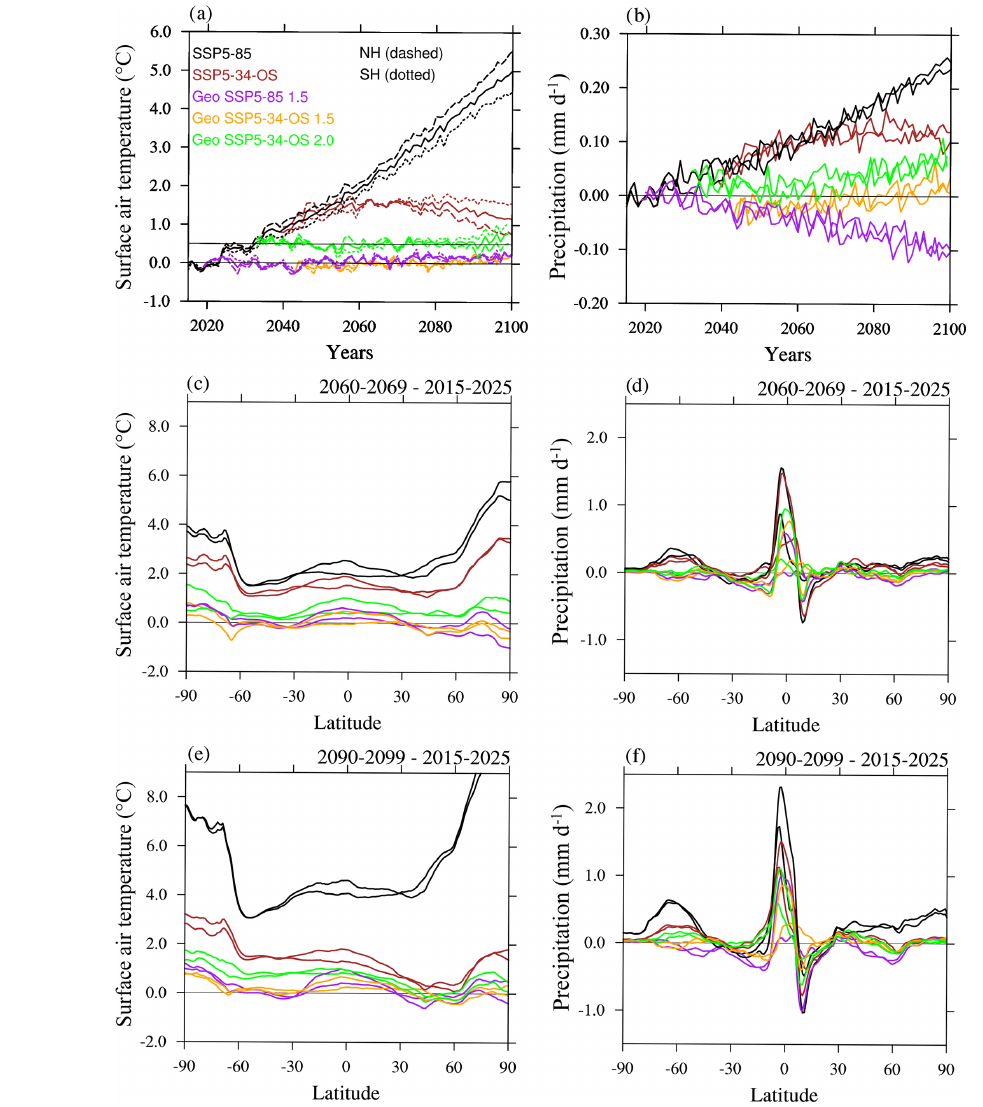
Figure 4. (a) Time evolution of the ensemble mean area-weighted annual mean surface air temperature with regard to 2010–2025 conditions, averaged over the globe (solid), over the Northern Hemisphere (dashed), and over the Southern Hemisphere (dotted) for different model experiments (different colors; see legend); (b) time evolution of area-weighted annual precipitation with regard to 2015–2025 conditions for different model experiments and ensemble members (different colors); differences of zonal mean surface air temperatures (c, e) and precipitation (d, f) with regard to 2015–2025 SSP5-85 conditions for values in 2060–2069 (c, d) and 2090–2099 (e, f) for the different model experiments (different